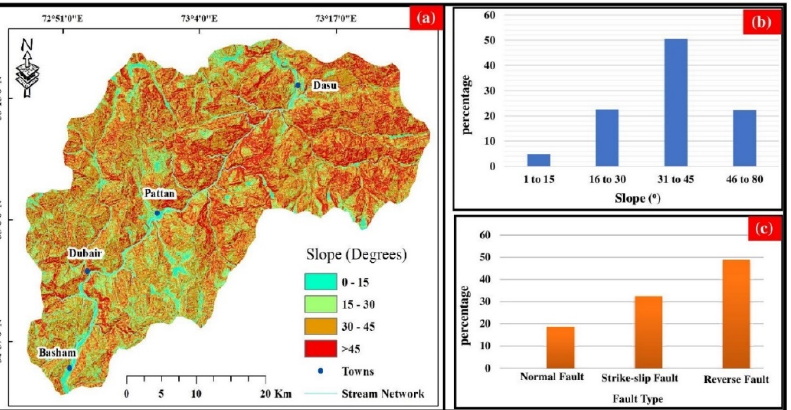
Figure 5. ( a ) Variation of slope in the study area. ( b ) More than 70% of the slope in the study area is greater than 30°. ( c ) Compressional stresses are dominant in the study area followed by strike ‐ slip and normal faulting.